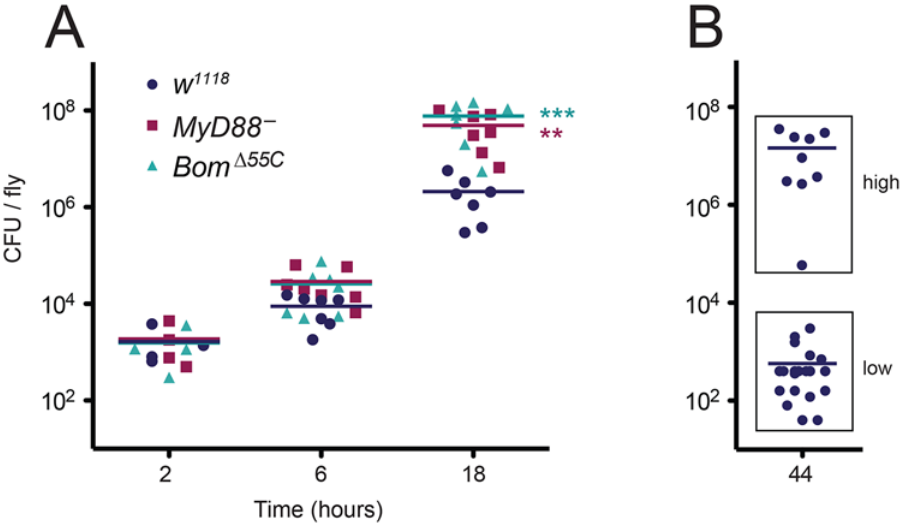
Fig 4. Deletion of the 55C Bom genes impairs resistance to E . faecalis infection rather than tolerance. (A) Points indicate the mean CFU/fly from individual experiments using pools of 5 – 10 flies per genotype after E . faecalis infection at the indicated time point. Horizontal bars represent the means of the (four or more) independent experiments shown. Significance was measured by two-way ANOVA and is relative to the wild type ( w 1118 ) at the same time point ( ** p < 0.01, *** p < 0.001). (B) CFU of individual wild-type ( w 1118 ) flies at 44 hours post-infection. Horizontal bars represent means. “ Low ” ( < 3800 CFU/fly) and “ high ” ( > 3800 CFU/fly) populations were measured simultaneously during four independent collections of individual flies. Data were binned (indicated by boxes), and means were calculated